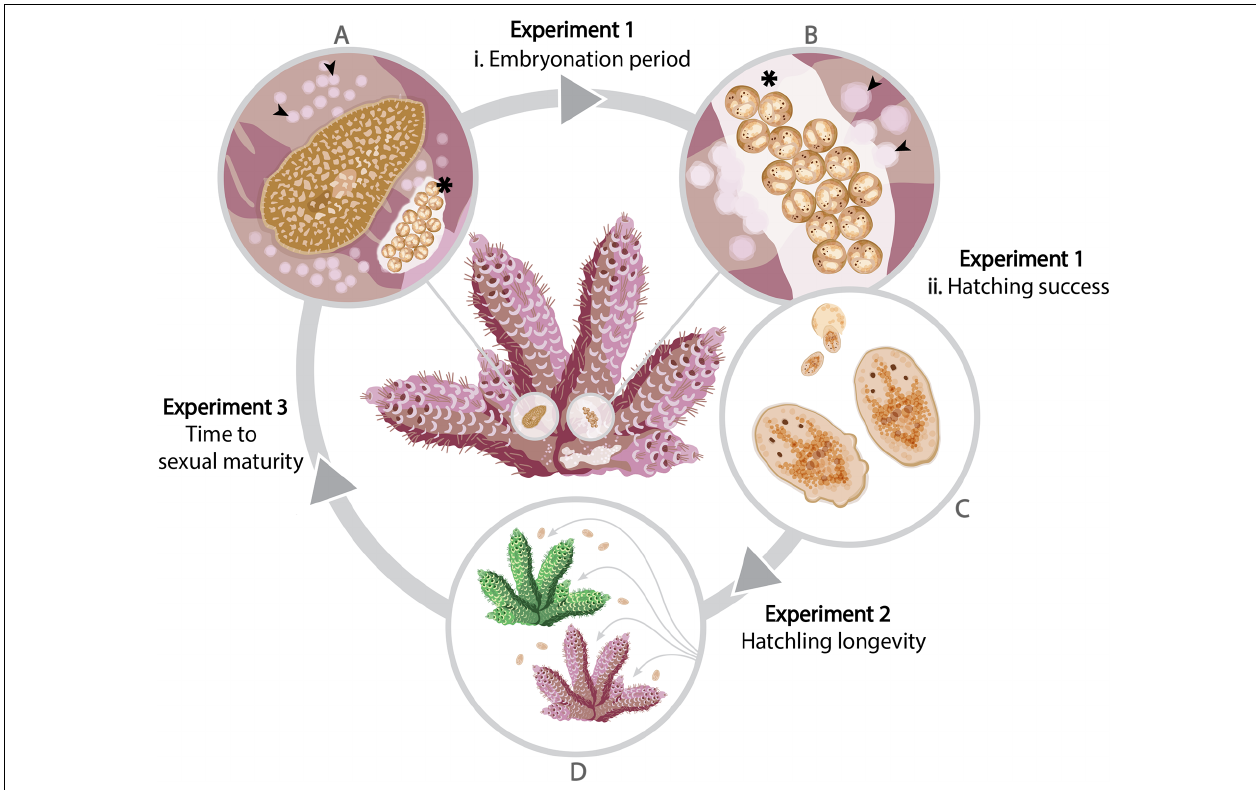
FIGURE 1 | A schematic of the life cycle of Prosthiostomum acroporae showing three experiments to assess the effect of temperature on development. Adult flatworms (A) leave circular feeding scars (arrowheads) on the coral tissue and deposit egg clusters (asterisk) on the coral skeleton. The time from (A) oviposition of the egg cluster to (B,C) hatching is referred to as the embryonation period. Hatchlings (D) may settle on their natal coral (pink), or find a new Acropora host (green), where they feed and develop to sexual maturity, as evidenced by the appearance of the next generation of